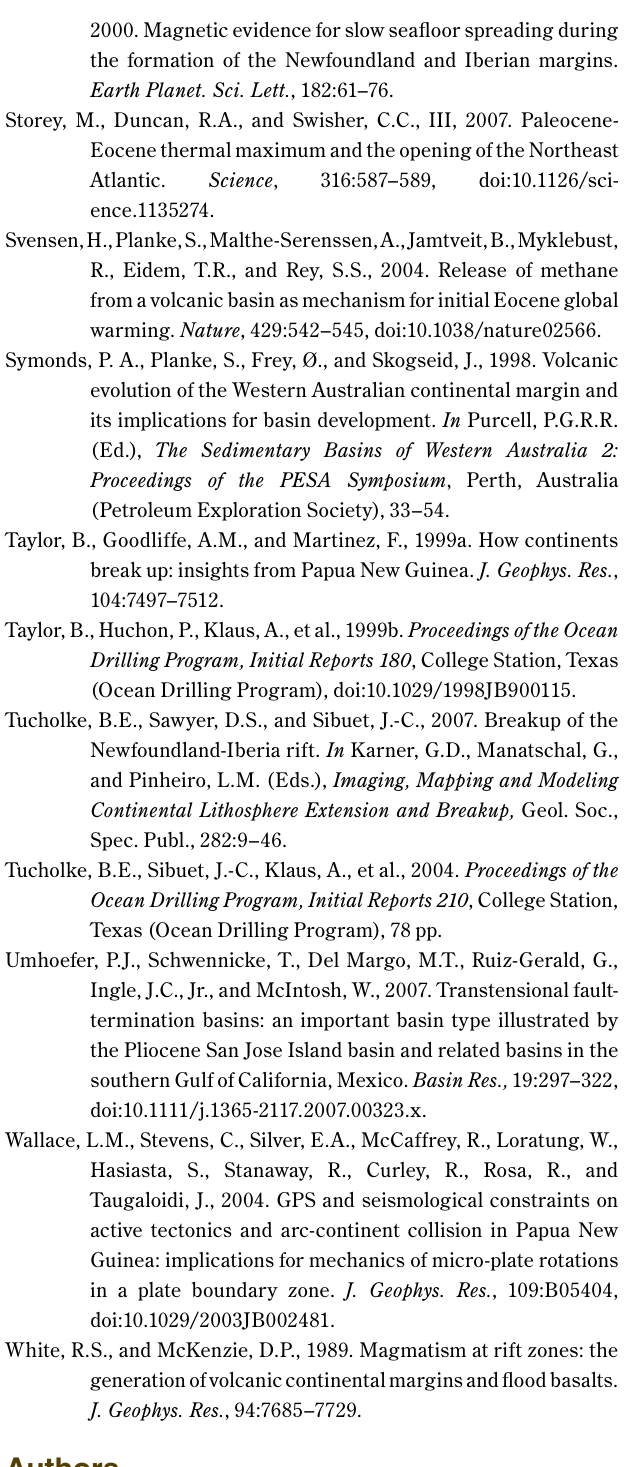
Figure 12. Photo courtesy of M. Storey (Roskilde Univer- sity Centre, Denmark). Figure 13. Photo courtesy of G. Manatschal (CGS-EOST, Strasbourg,